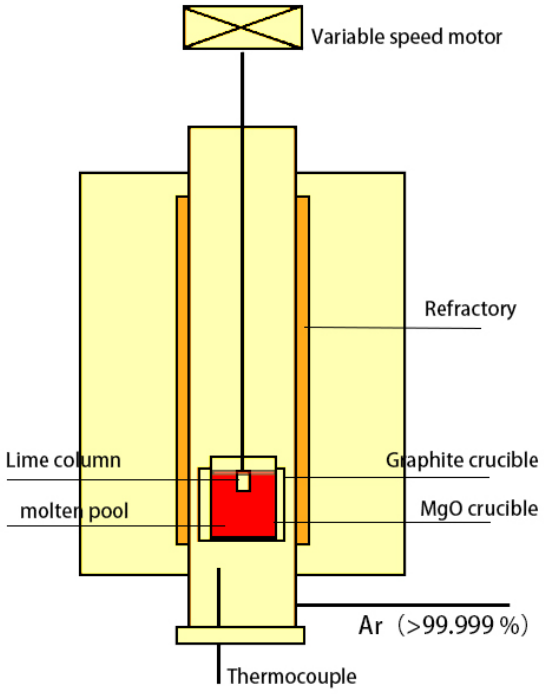
Figure 2. Experiment equipment.